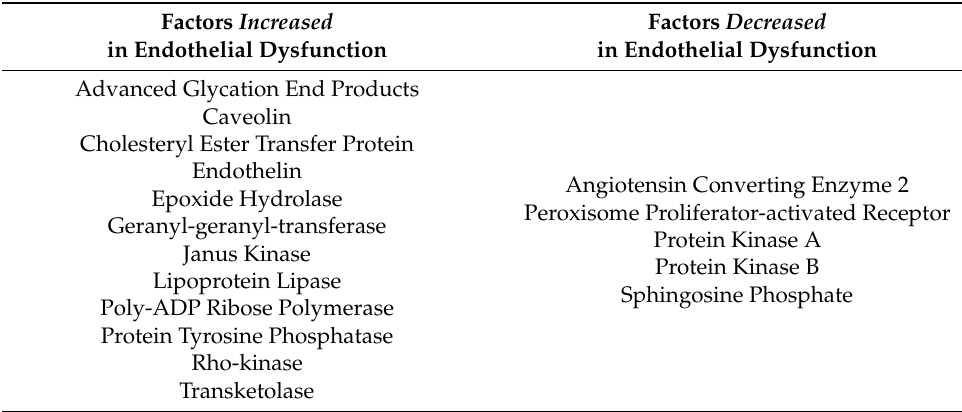
Table 3. Signaling systems involved in endothelial dysfunction, potential targets for polymer-based approaches